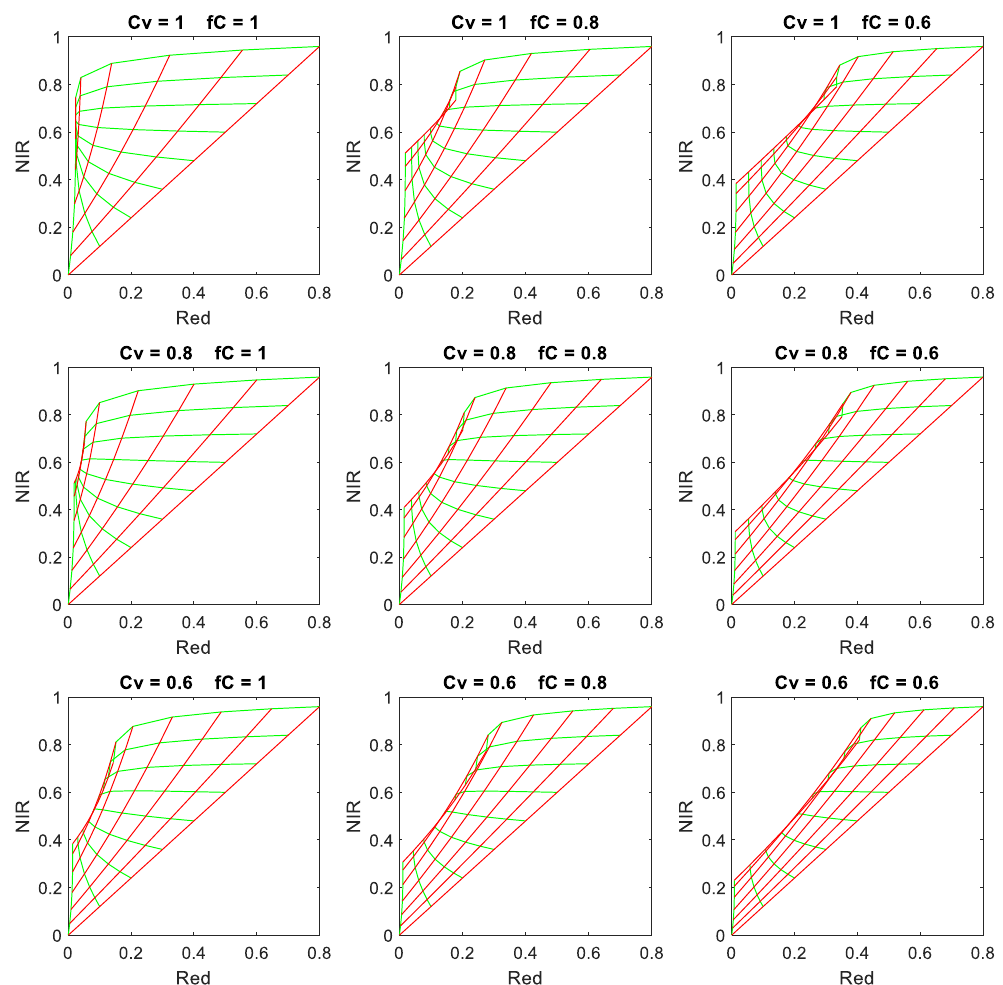
Figure 5. Effects of crown clumping and mixed-pixel heterogeneity on the red–NIR bi-hemispherical reflectance feature space. Lines of varying soil brightness are shown in red (levels 0, 0.1, 0.2, . . . , 0.8 in R s ). Lines of varying crown LAI are shown in green (levels 0, 0.2, 0.5, 1, 2, 4, 8). Vertical crown cover ( C v ) and fractional cover ( f C ) are shown in the title of each subplot.